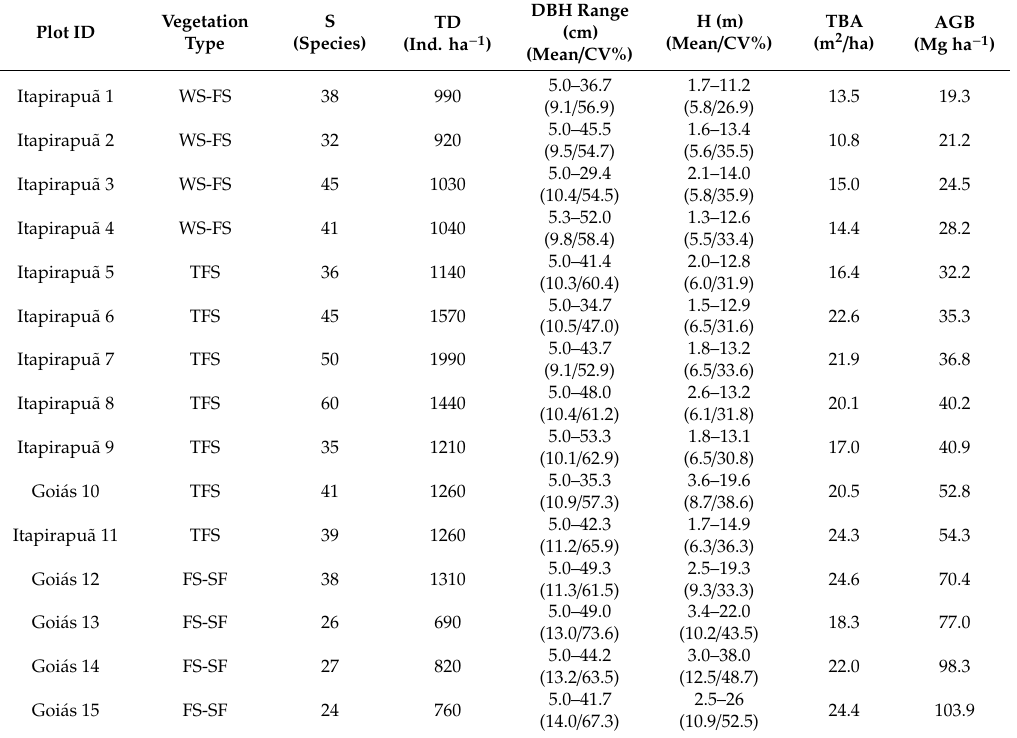
Table 1. Floristic and structural characterisations of the plots located in fragments of the native Cerrado vegetation in the Rio Vermelho watershed, Goi á s State, Brazil. WS-FS = savanna-cerrad ã o transition zone, TFS = cerrad ã o, FS-SF = cerrad ã o-seasonal forest transition zone; S = species richness, TD = tree density, DBH = diameter at breast height, H = height, TBA = tree basal area, AGB = aboveground biomass, and CV = coe ffi cient of